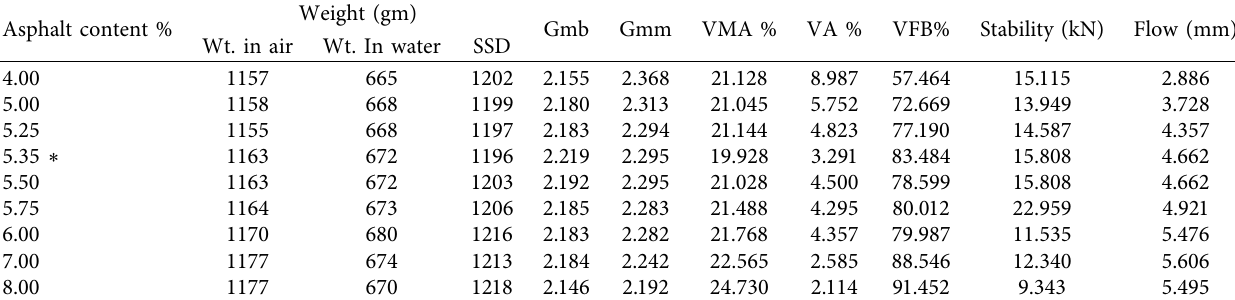
Table 12: Volumetric parameters of the AC mix with 8.0% CSD filler.